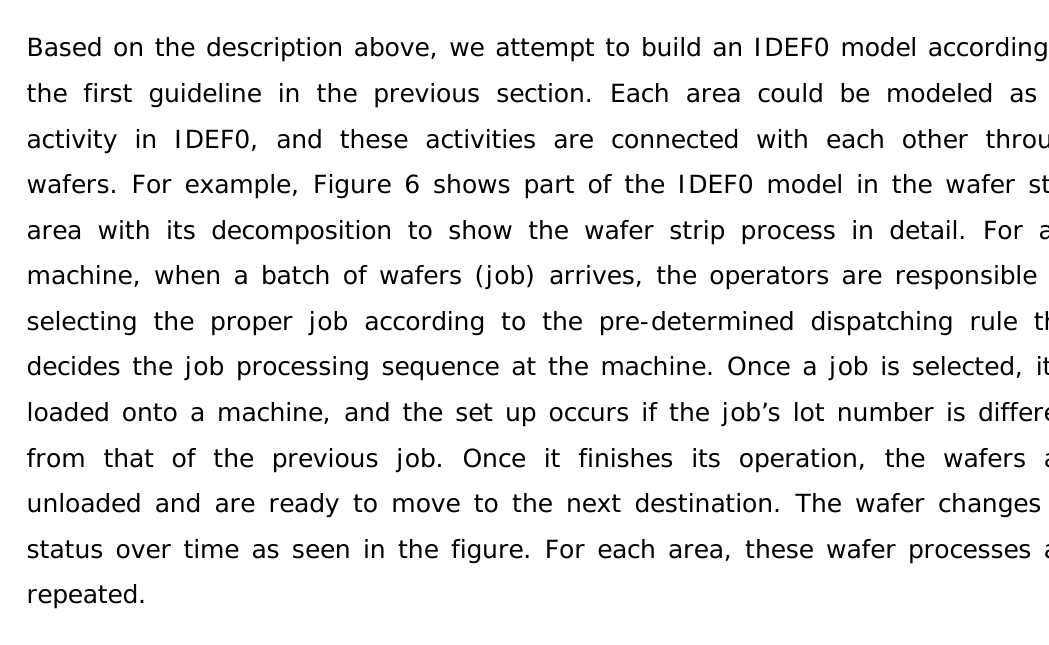
Table 4. “Facility data by